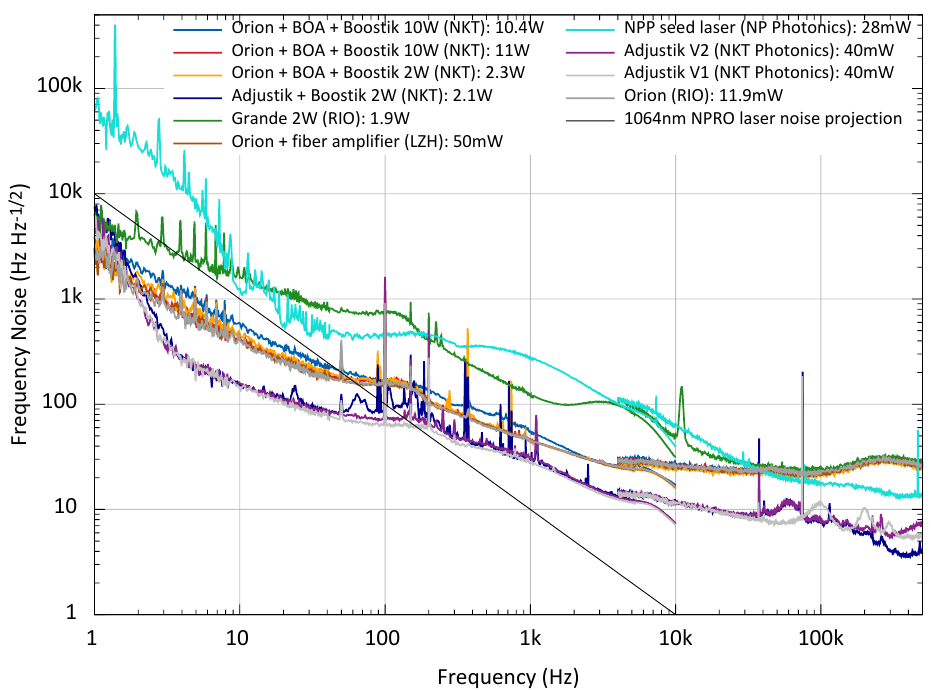
Figure 2. The free-running frequency noise of the different seed lasers and MOPA combinations is shown. The frequency noise of the MOPA systems is dominated by their seed laser